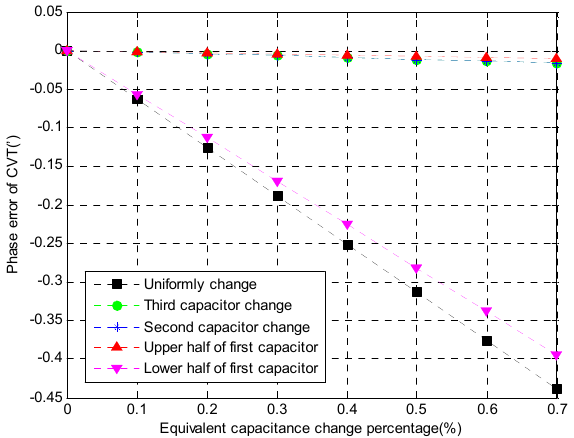
Figure 11. CVT phase error with different equivalent capacitance.